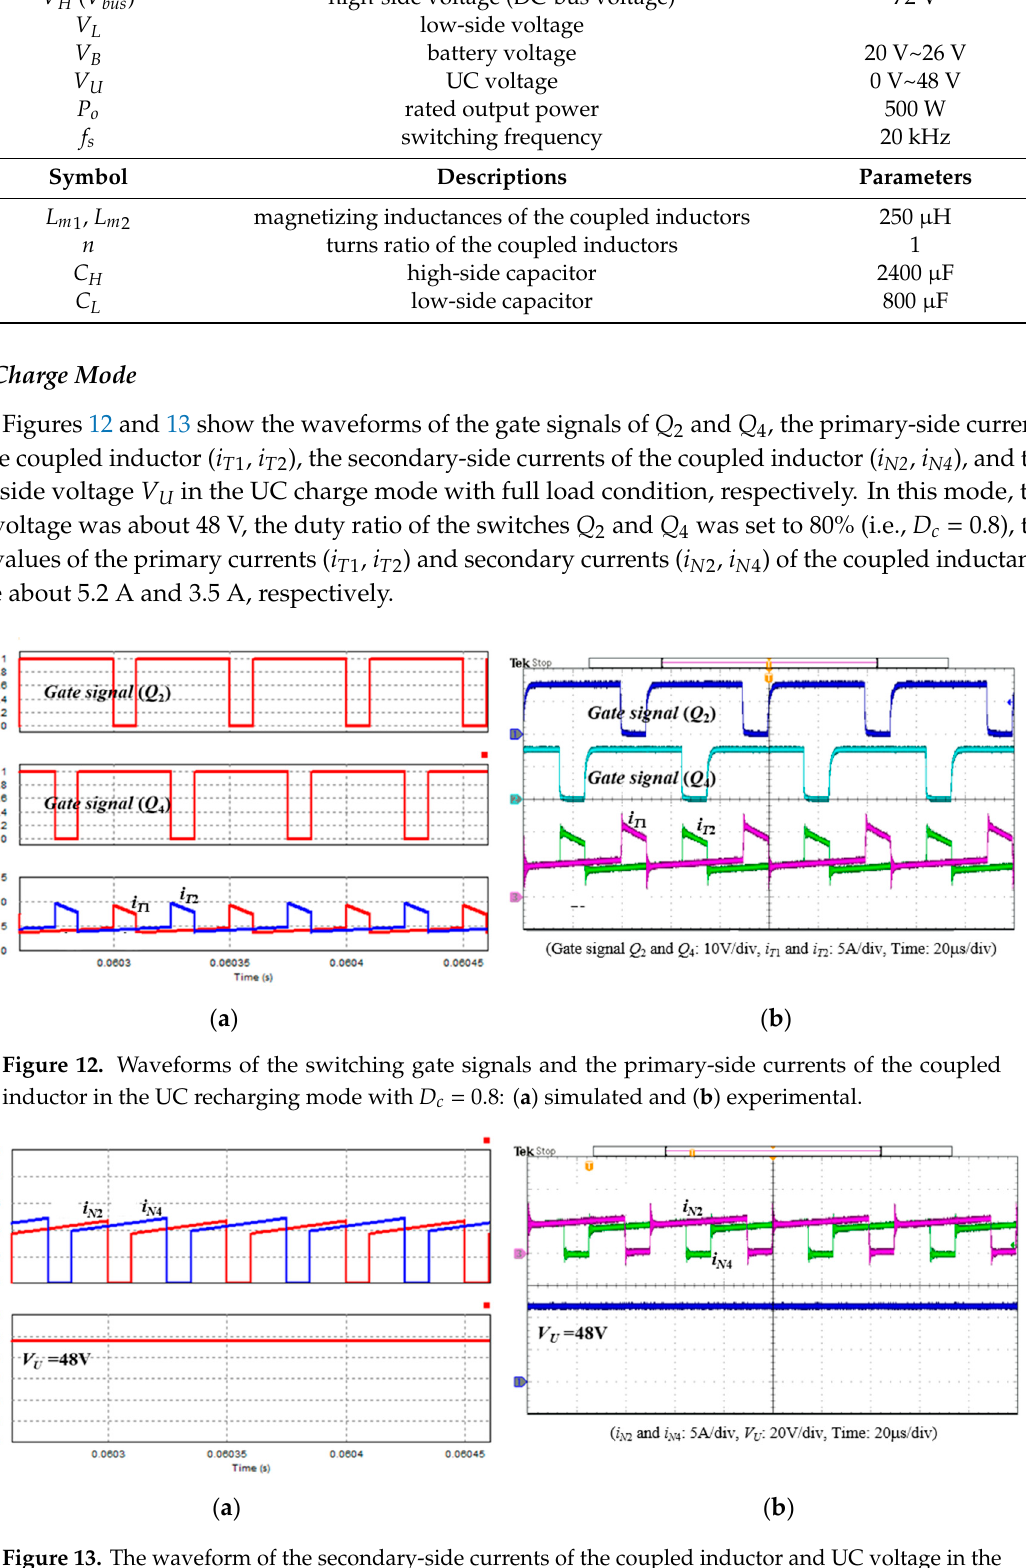
Figure 13. The waveform of the secondary-side currents of the coupled inductor and UC voltage in the UC charge mode with D c = 0.8: ( a ) simulated and ( b ) experimental.